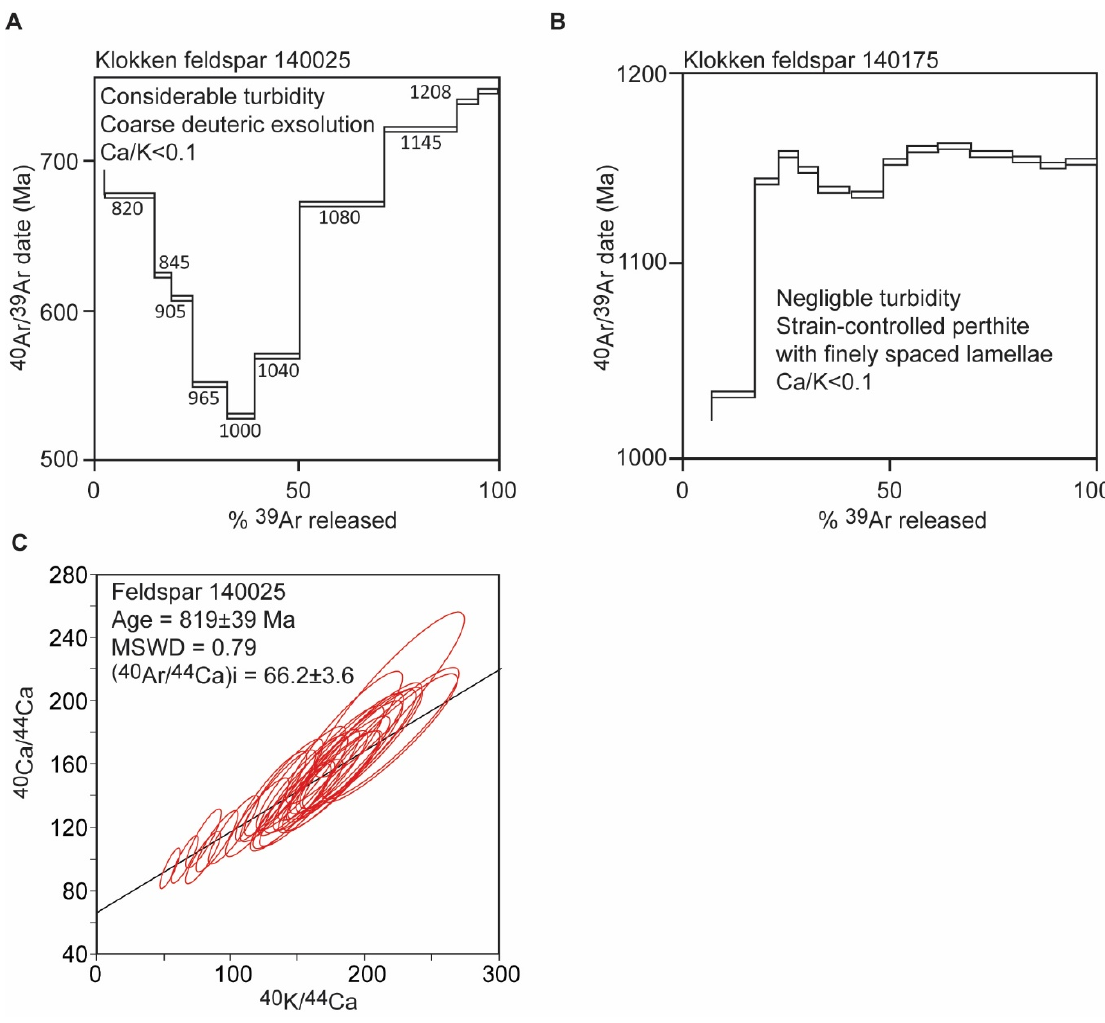
Figure 5. ( A ) Step-heating spectrum for alkali feldspar from sample 140025 of the Klokken layered series, which has considerable turbidity and coarse deuteric alteration, with 40 Ar/ 39 Ar step dates that are considerably younger than the zircon U-Pb baddeleyite age of the syenite [67]. ( B ) Step-heating spectrum for alkali feldspar from sample 140175 of the Klokken layered series, which is a strain controlled microperthite that lacks turbidity, with a total fusion age (1125 ± 16 Ma) that suggests <5% of 40 Ar has been lost [67]. ( C ) K-Ca data for alkali feldspar from sample 140025. The young isochron age relative to the U-Pb baddeleyite age was used by Harrison et al. (2010) [70] to conclude that the Klokken syenite was affected by aqueous fluid-mediated dissolution-reprecipitation, and the 40 Ar/ 39 Ar data are mainly not a consequence of thermally driven 40 Ar loss.